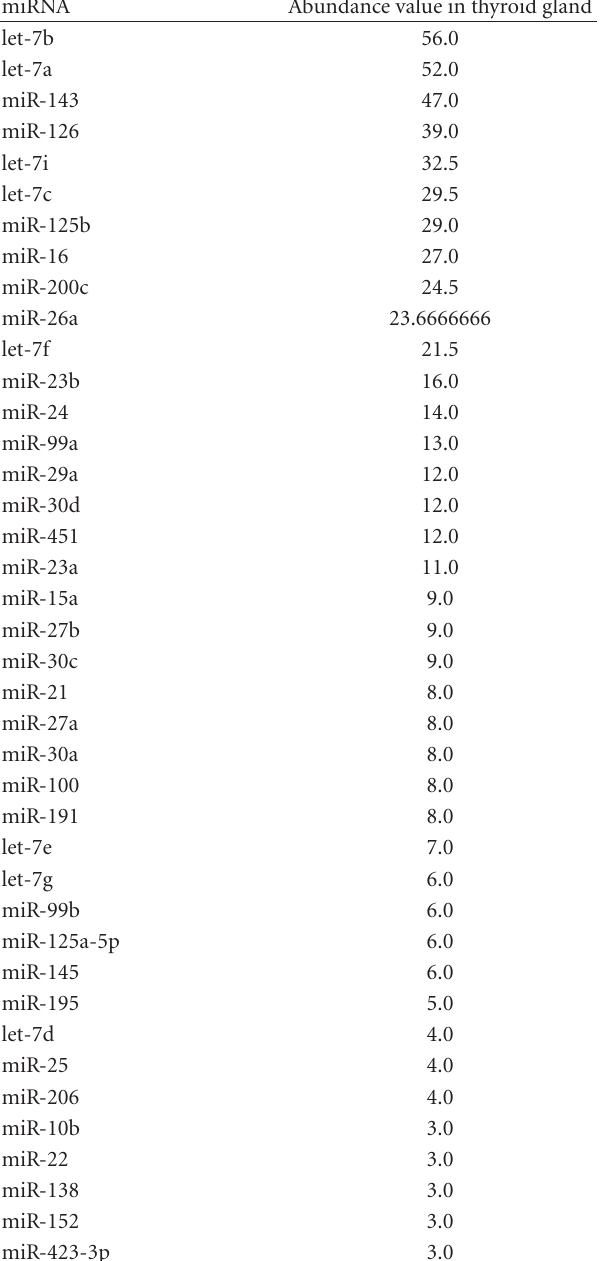
Table 1: Most abundantly expressed miRNAs in human healthy thyroid gland . The table reports the most abundantly expressed miRNAs in human normal thyroid gland; data are derived from http://www.mirz.unibas.ch/cloningprofiles/. The tool screened a total of 768 human miRNAs. Only miRNAs with an abundance value over 3.0 have been reported in the